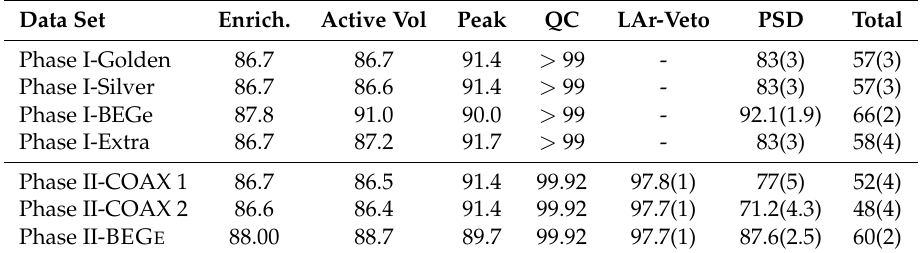
computation. 1/2